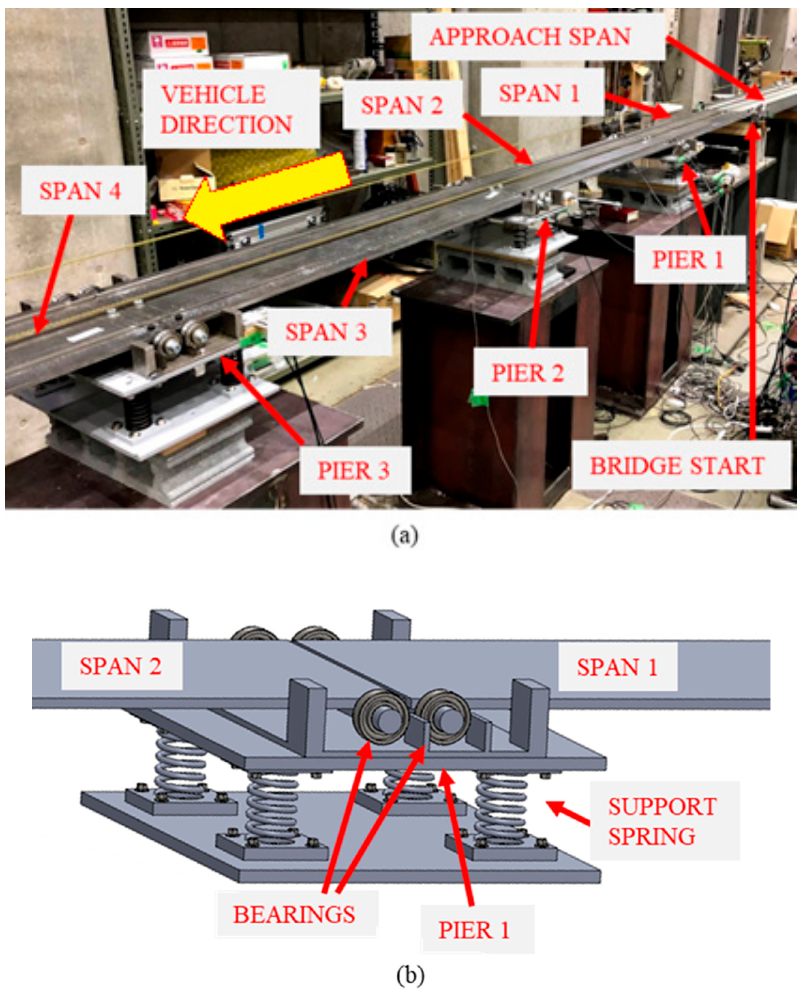
Figure 6. Laboratory-scaled bridge ( a ) complete bridge ( b ) schematic of Pier 1 supported on springs.